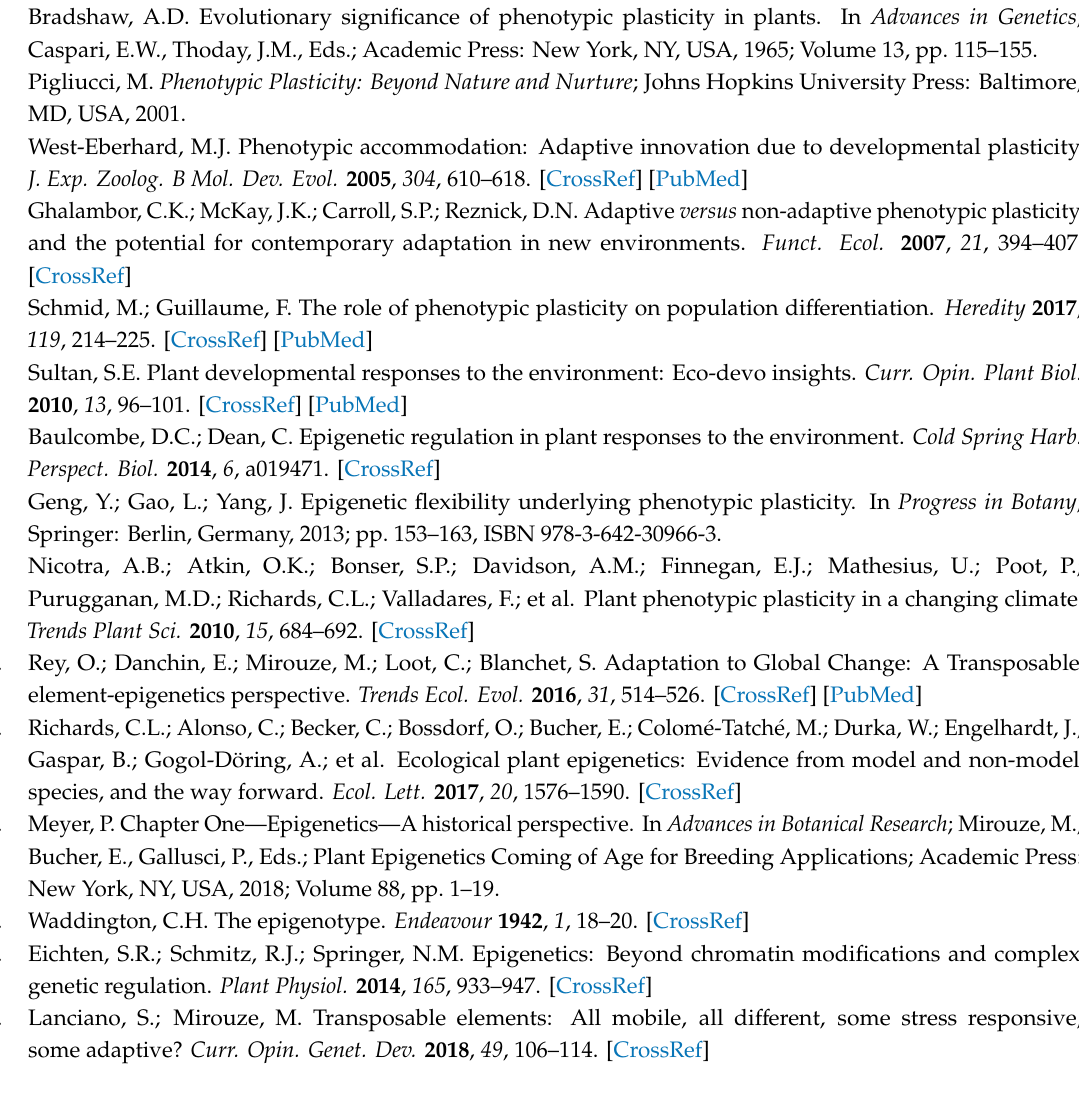
Figure S1: Average light spectrum and intensity analysis by spectrophotometer acquisition over 15 minutes of recording on a sunny day in one location for each treatment; Figure S2: Shade avoidance response in A. majus highly inbred lines; Figure S3: Average trait values across di ff erent levels of shade; Figure S4: Global DNA methylation variation with the number of branches in highly inbred lines of A. majus ; Table S1: E ff ects of shade and highly inbred lines on phenotypic traits; Table S2: E ff ects of methylation and highly inbred lines on phenotypic